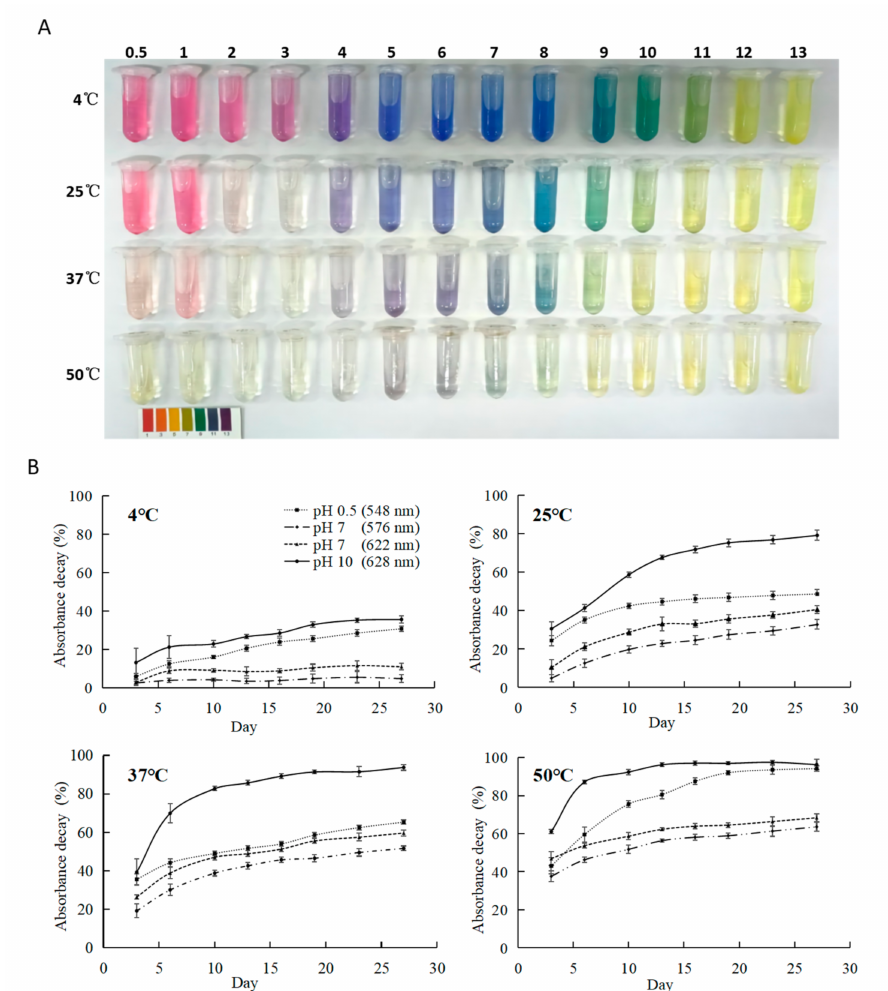
Figure 4. Combined effects of pH and temperature on the stability of CTAEs. ( A ) Color of CTAEs after 65 days’ storage in dark at 4, 25, 37, and 50 ◦ C, respectively. Below is the color reference by universal pH indicator paper. ( B ) Absorbance decay percentages of CTAEs at pH 0.5 ( λ max at 548 nm), pH 7 ( λ max at 576 nm and 622 nm) and pH 10 ( λ max at 628 nm) during 27 days’ storage in dark at 4, 25, 37, and 50 ◦